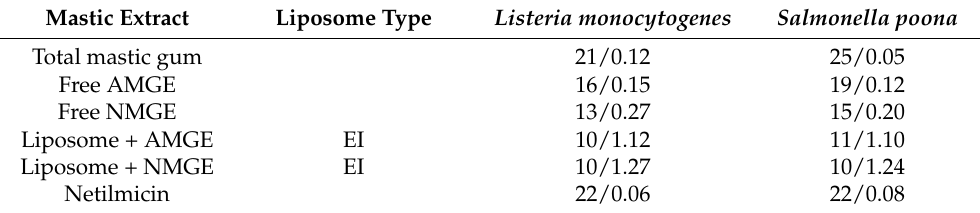
Table 4. Activity against foodborne bacteria (inhibition zone and MIC mg/mL) of mastic extracts before and after liposome